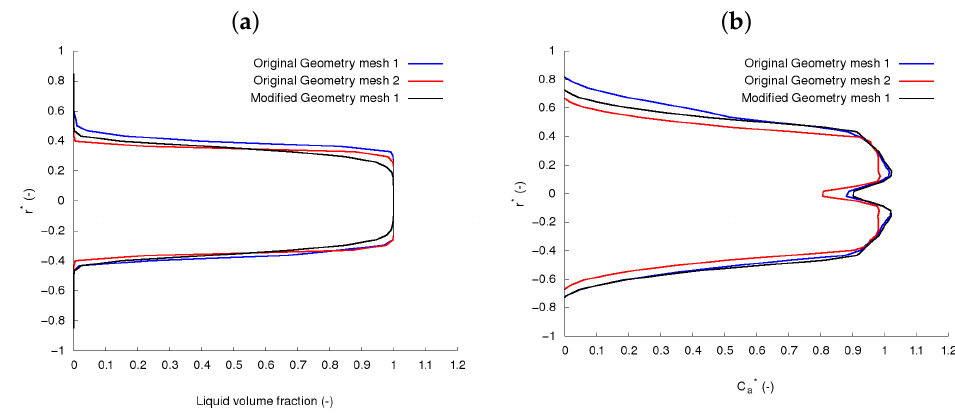
Figure 10. ( a ): Liquid volume fraction profile in the section located at a distance s = 1.42 × d nozzle downstream of the nozzle outlet. ( b ): Dimensionless axial velocity profile in the section located at a distance s = 1.42 × d nozzle downstream of the nozzle outlet. The profiles are extracted along the green line shown in Figure 9. Simulations for a needle stroke of 50% with the “SUPERBEE” limiter. Table 4. Differences between the discharge computed with the SUPERBEE limiter and the mea- sured